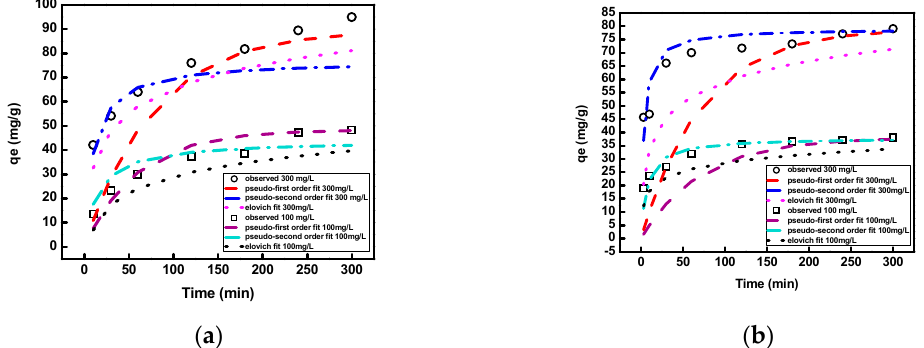
Figure 6. Adjustment to the kinetic models for the adsorption of 2,4-D on ( a ) AC and ( b ) MAC at 100–300 mg/L and 25 °C. Table 2. Kinetic parameters of the models studied for 2,4-D on AC at different initial concentrations and 25 °C.